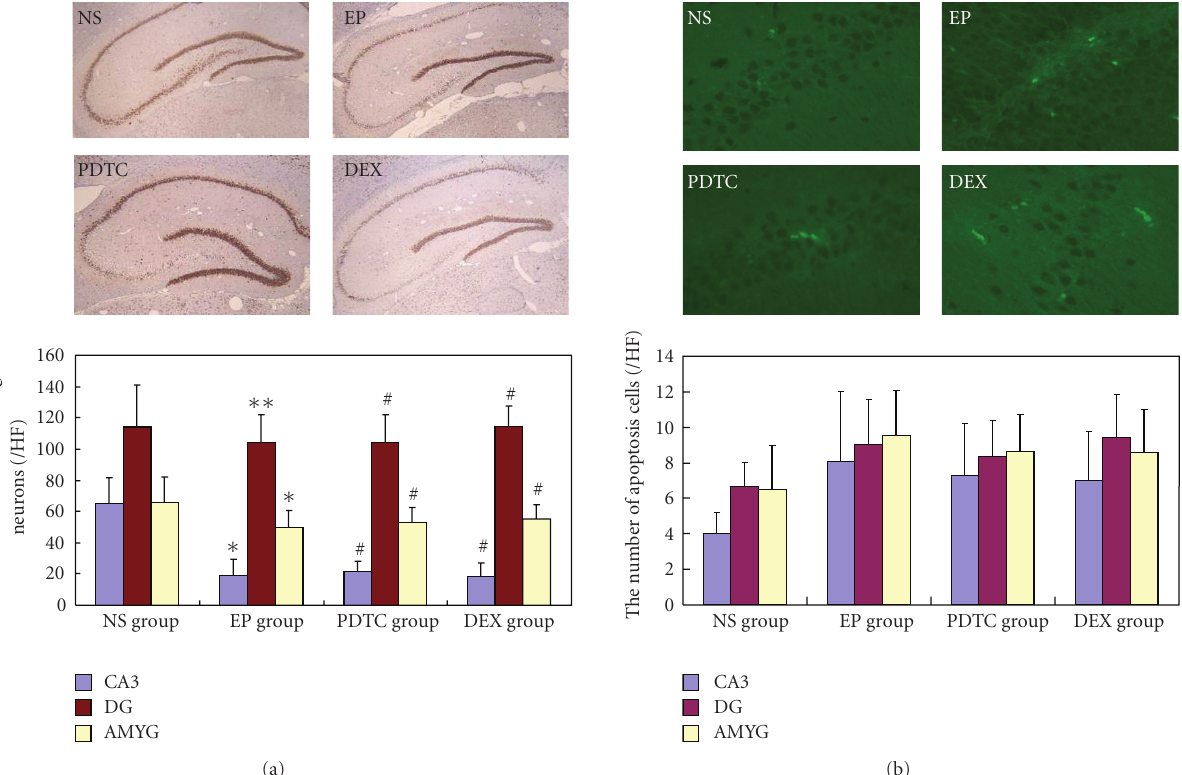
Figure 2: PDTC and DEX pretreatment failed to prevent KA induced brain cell loss. (a) Representative photos of immunohistochemistry staining with anti-NeuN antibody ( × 100). Immunohistochemistry staining was performed to check the surviving neurons in the brain. The shape and number of neurons is normal in NS group (NS) , while significant neuronal loss in the CA3 area was observed 24 h after KA micro- injection in the EP group (EP) . In the KA induced rat pre-treated with PDTC (PDTC) or DEX (DEX), the survival neuron numbers did not significantly increase compared to the EP group. Additionally, the neuron number in dentate gyrus was not significantly changed among the four groups. Histogram showed the number of surviving neurons in the indicated brain area of each group (/HF). ∗ P < . 05 versus NS group; ∗∗ P < . 01 versus NS group; # P > . 05 versus EP group, CA3, hippocampus CA3 area; DG: dentate gyrus; AMYG: amygdaloid nuclear. (b) Representative photos of TUNEL staining (times 200). Cells undergoing apoptosis were detected (labeled by FITC and shown in green) in each group 24 h after KA or vehicle injection. KA injection did not increase TUNEL positive cells significantly; there was no di ff erence in TUNEL positive cell numbers between PDTC/DEX and EP groups. CA3, P = . 052; DG, P = . 65; AMYG, P = . 061, by ONEWAY-ANOVA test; CA3, hippocampus CA3 area; DG: dentate gyrus; AMYG: amygdaloid